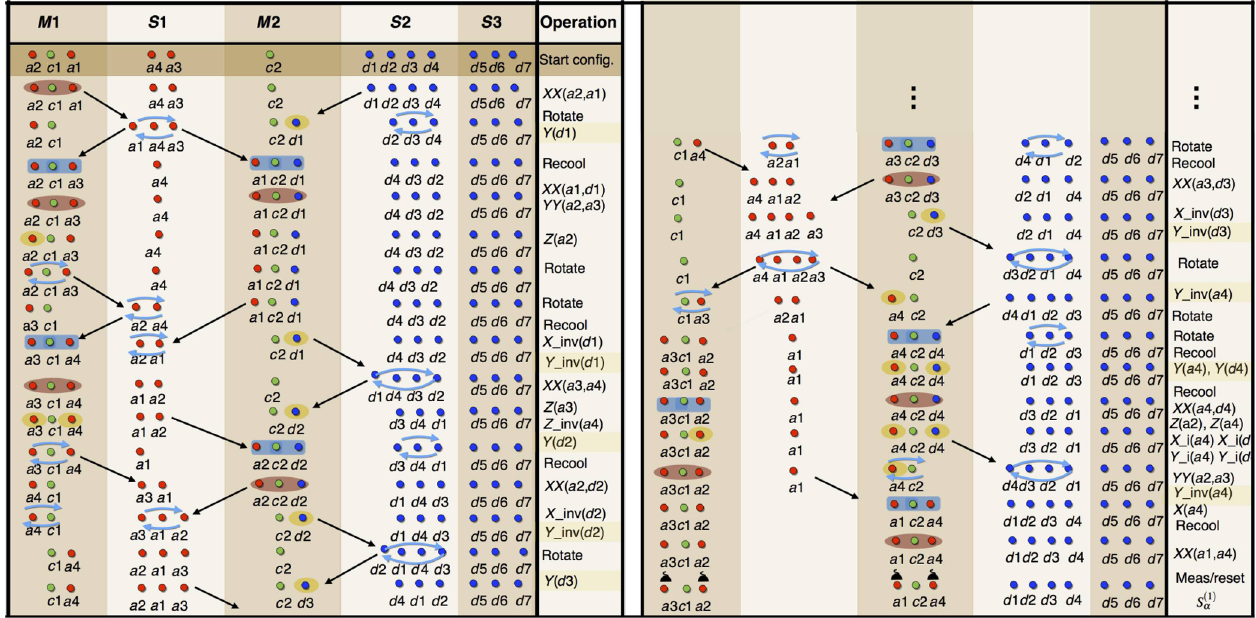
FIG. 22. Real-space representation of the shuttling-based, two-species QEC cycle with a DiVincenzo-Aliferis scheme: We represent the operations for the fault-tolerant DiVincenzo-Aliferis readout of a single stabilizer operator S ð and we use the same conventions as in Figs. 15, 18, 19, and